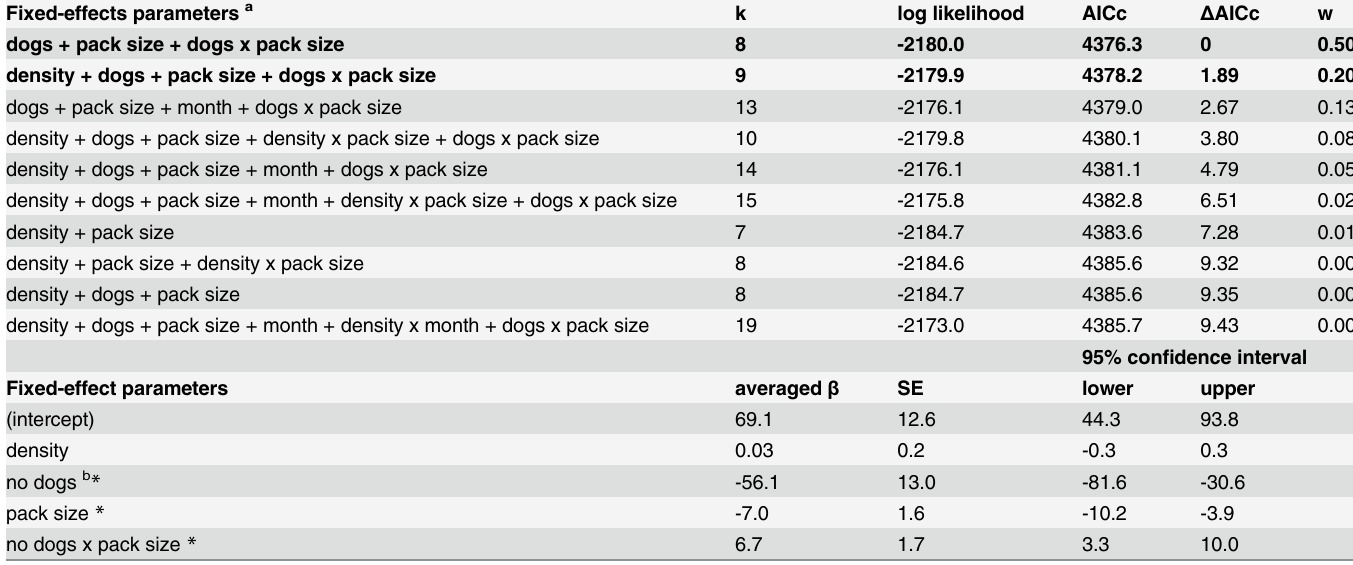
Table 6. Results of selection and averaged fixed-effects coefficients of mixed-models exploring the effect of wolf population density, pack size, presence of a sympatric free-ranging dog population, and month of sample collection on fecal cortisol metabolites levels in wolves in Abruzzo, Lazio e Molise National Park (Italy), Mercantour National Park (France), and Yellowstone National Park (USA), 2005 – 2009. Only candidate models with Δ AICc < 10 are shown. We used candidate models with Δ AICc < 2 (bold face) for model coefficient averaging. Fixed-effects parameters a